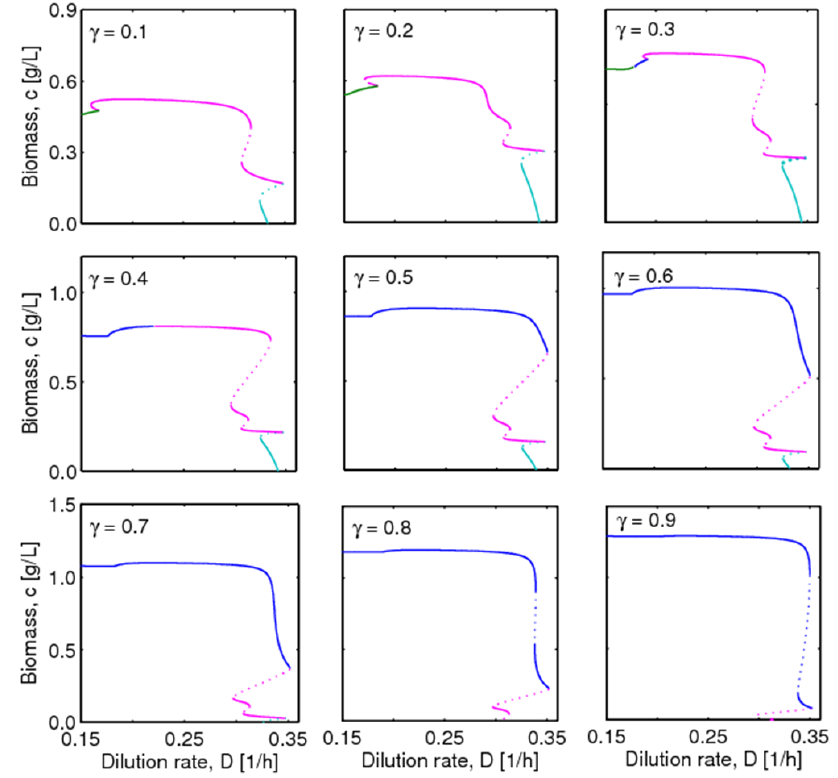
Figure 7. Hysteresis of biomass concentration profiles with different γ